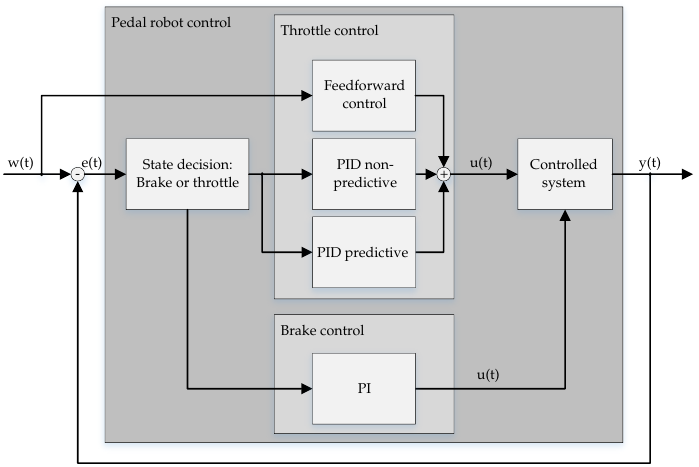
Figure 6. Schematic representation of the pedal robot control